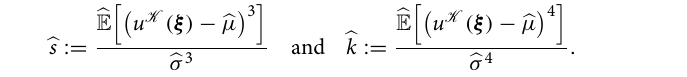
The skewness of a distribution measures its asymmetry and a distribution is commonly said to be fairly sym- s 1 / 2 , moderately skewed if 1 / 2 s 1 and highly skewed if s 1 . In the small range case, we metrical if | | ≤ ≤ | | ≤ | | ≥ II ) , and Fe . In the large range observed a slight asymmetry for Ca 2 + and Mg 2 + and a high asymmetry for Al , S ( − pe , Si and log p CO case, the asymmetry became important for all the QoIs except for pH , pH . The kurtosis 10 2 + of a distribution measures the combined weight of the tails relative to the rest of the distribution. It is common to compare the kurtosis to 3 which is the kurtosis of a normal distribution; a high kurtosis ( k > 3 ) indicates heavy tails while low kurtosis ( k < 3 ) denotes light tails. In the small range case, the kurtosis is between 2 and 4 except II ) which have strong heavy-tailed distributions and Si due to its piecewise linear distribution. In for Fe and S ( − the large range case, we observed that the kurtosis of each distribution increases substantially (except for pH , pH pe , Si and log p CO ), meaning that the heaviness of the tails grows in importance. We noted that Fe was 10 2 + the only quantity of which the distribution was more peaked for the larger parametric domain; the mean values obtained with each of these cases were significantly different but the medians were very close (Fig. 2). Linear correlations. Linear correlation between two random variables u and v were measured with the 1, 1 Pearson’s correlation coefficient r ( u , v ) defined as follows ∈ [− ]